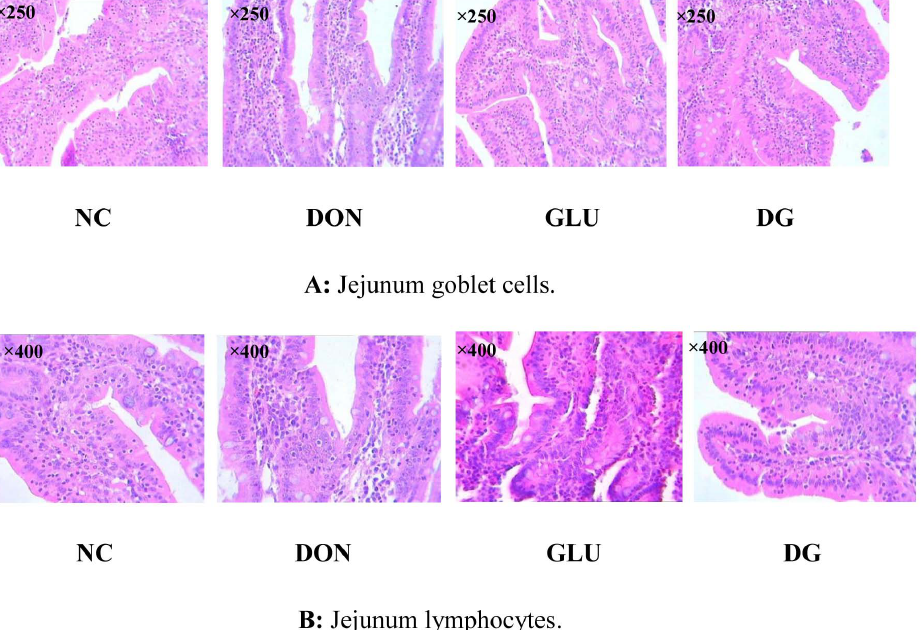
Figure 6. Image of jejunum goblet cells and jejunum lymphocytes. A: Jejunum goblet cells ( 6 250). B: Jejunum lymphocytes ( 6 400). Dietary treatments were NC, an uncontaminated basal diet, DON, the basal contaminated with 4 mg/kg deoxynivalenol, GLU, uncontaminated basal diet with 2% (g/g) glutamic acid supplementation, and DG, deoxynivalenol-contaminated (4 mg/kg) basal diet with 2% (g/g) glutamic acid supplementation. n=7 for treatments.